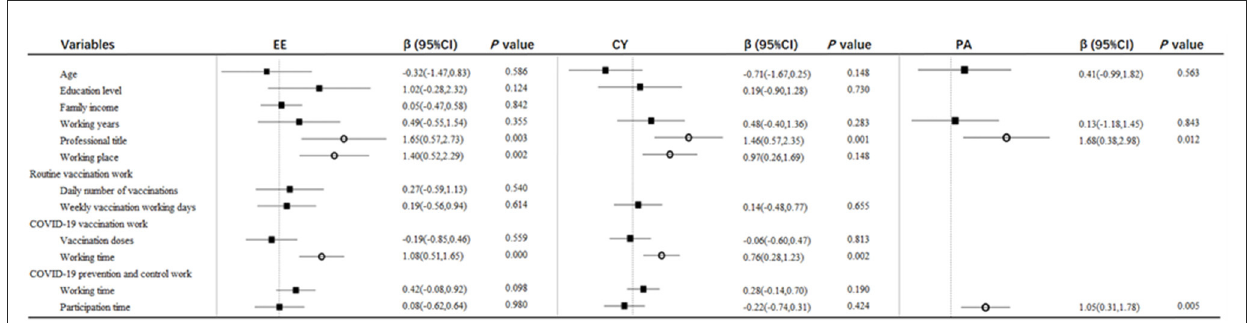
FIGURE3 Multivariable analysis of the risk factors for EE, CY, and PA among vaccination staff.